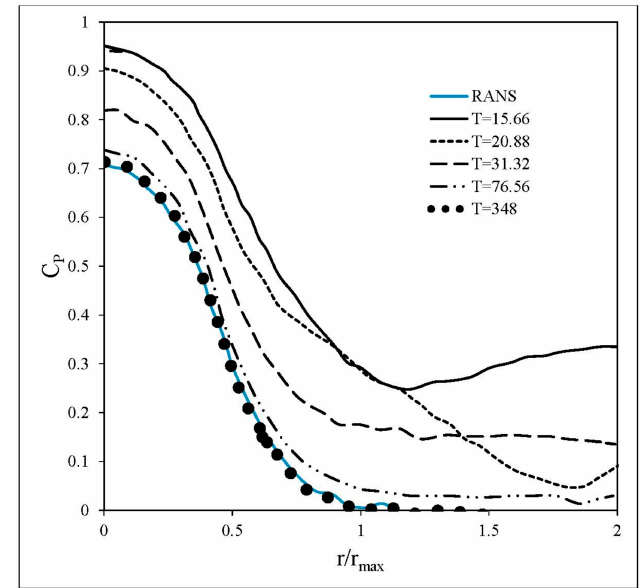
Figure 6. Radial distribution of the mean pressure coefficient obtained from present steady and transient simulations. Radial distribution of the mean pressure coefficient obtained from the steady and transient simulations. The pressure is taken from y Re =